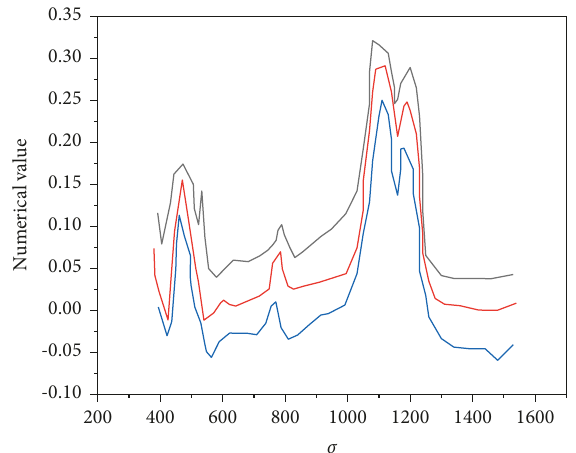
Figure 3: B-1 Raman spectra of chromogenic minerals of south red agate.